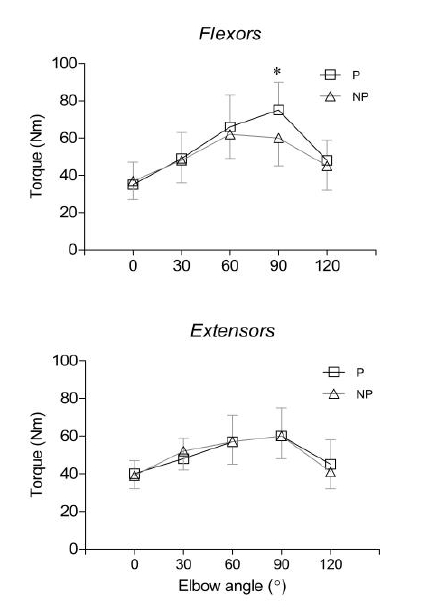
Figure 1. Torque-angle relation for elbow flexor (top) and elbow extensor (bottom) muscles. Asymmetry was observed only for the preferred limb at the elbow joint angle of 90°. (* indicates p<0.05; P=preferred; NP =